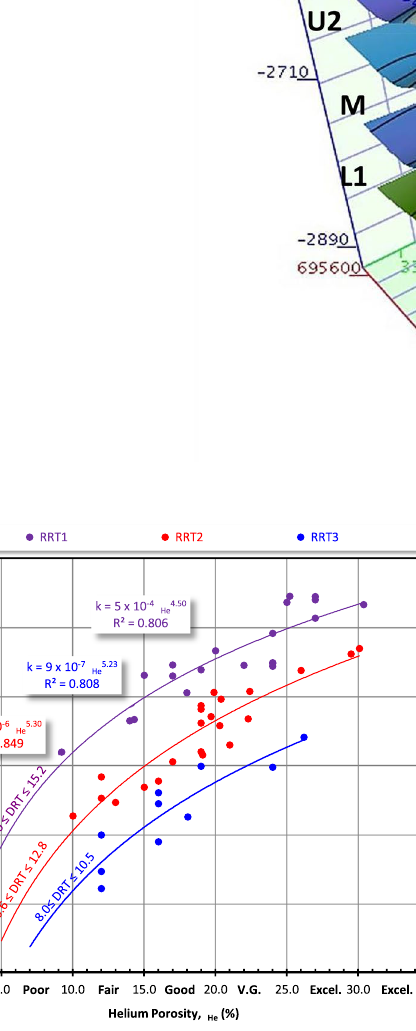
35 values of the